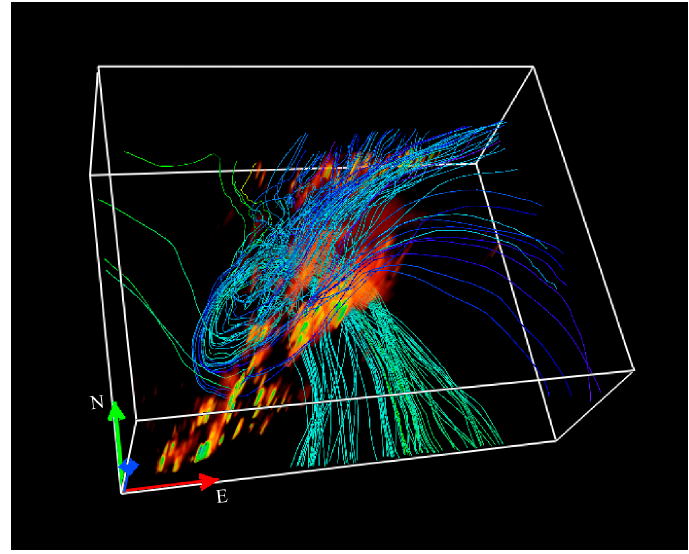
Figure 15. Three-dimensional diagram of flow field (streamlines) and radar echo reflectivity (shaded) at the initiation time of the convective cells over the mountains.